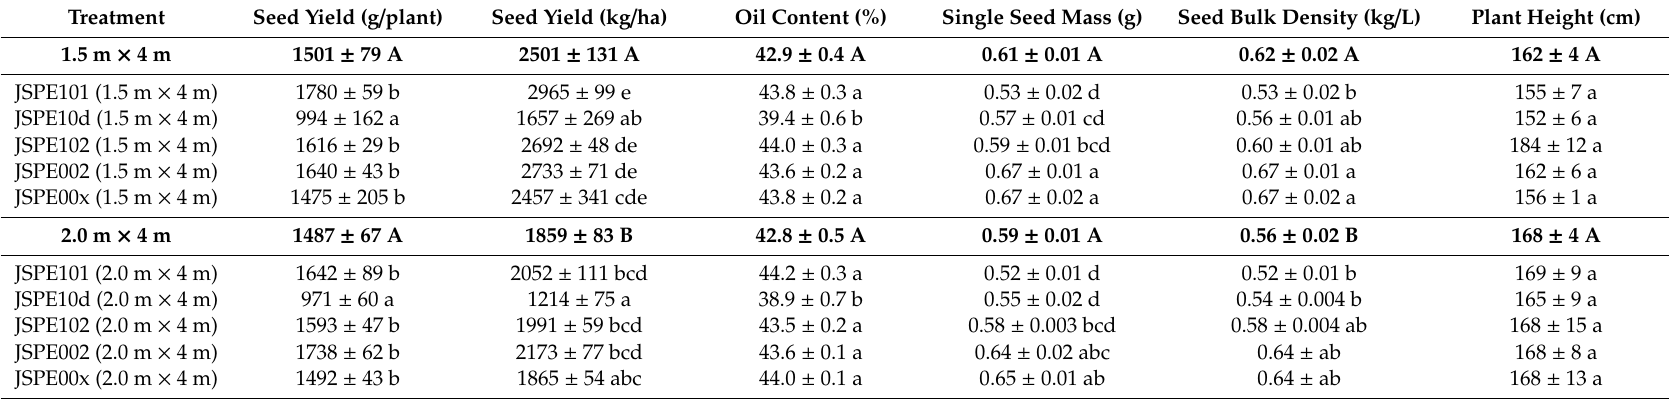
Table 3. Means ± standard errors at Ihosy for spacings averaged over all half sib families (in bold) and per half sib family in the corresponding spacing (3rd year). Di ff erent capital and small letters, respectively, indicate significant di ff erences at α = 5%.